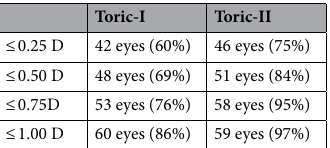
Table 2. Refractive astigmatism prediction errors. D diopters; Significant difference was found between groups (p =